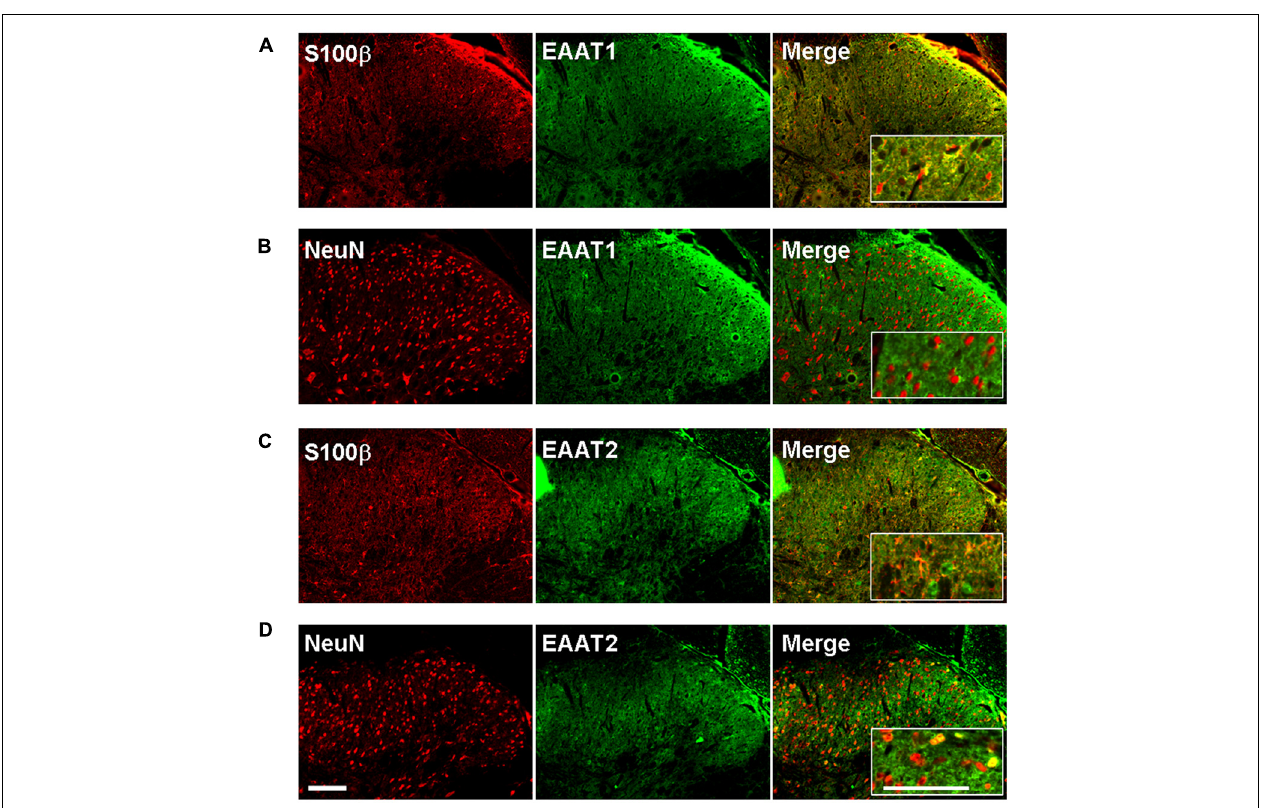
FIGURE 8 | EAAT-1 immunofluorescence is exclusively astrocytic. (A) colocalization (yellow, right panel) between: EAAT-1 (green) and astrocytic s100 β (red); (B) No colocalization between EAAT-1 (green) and neuronal